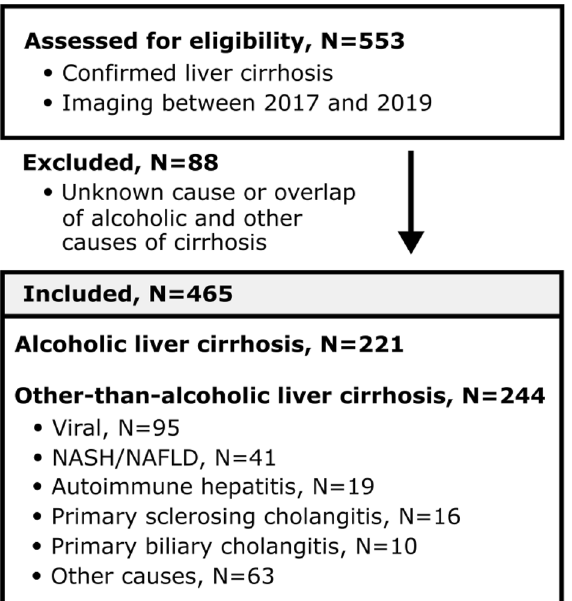
Figure 1. Study inclusion flow chart. Patients with confirmed diagnosis of liver cirrhosis who underwent liver MRI between 2017 and 2019 were evaluated for inclusion. Patients with unknown causes of liver cirrhosis and with documented overlap of alcoholic liver cirrhosis with other causes were excluded from the analysis. The final cohort consisted of 465 patients. Those patients were separated according to liver cirrhosis etiology into patients with ( a ) alcoholic liver cirrhosis (N = 221) and ( b ) other-than-alcoholic liver cirrhosis (N = 244). Abbreviations: NAFLD/NASH non-alcoholic fatty liver disease/non-alcoholic